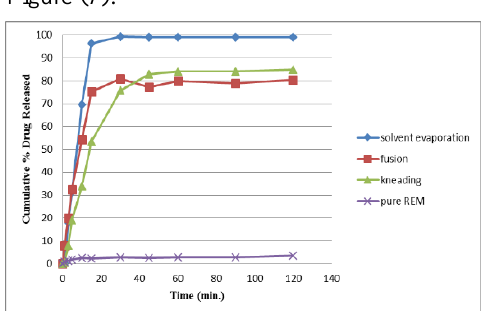
Figure 7. Effect of preparation methods of rem-tpgs solid dispersion at a ratio (1:15) in 0.1 N HCl dissolution medium at 37°c.